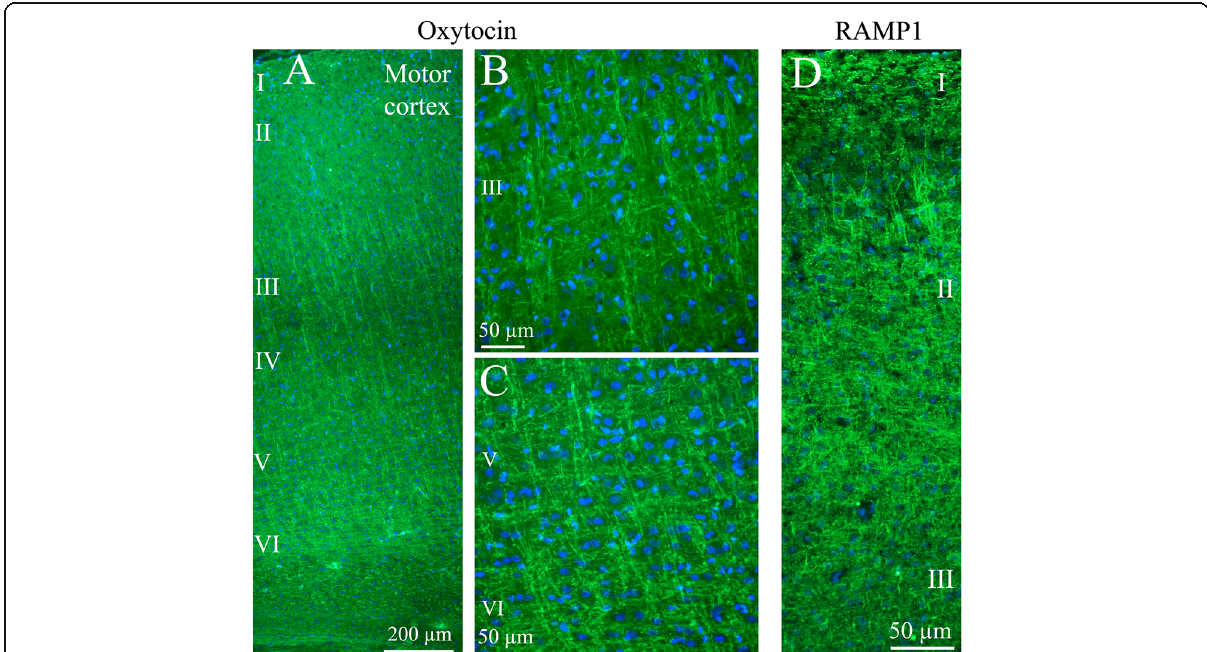
Fig. 4 Oxytocin immunohistochemistry of the cerebral cortex. a . Thin fibers of layers III-VI of the motor cortex displayed oxytocin immunoreactivity. b and c. These fibers spanned through the layers in a delicate and well-defined pattern. Layer III ( b ) and layers V-VI ( c ) are shown in a higher magnification. d . As a comparison, the calcitonin gene-related peptide (CGRP) receptor component (receptor activity- modifying protein 1) RAMP1 is shown in the right panel. These results have been published earlier [25]. We showed that RAMP1 positive fibers spanned through the cortical layers, but here layer II positivity was found. In addition to the transversal positive fibers, RAMP1 positive horizontal fibers were